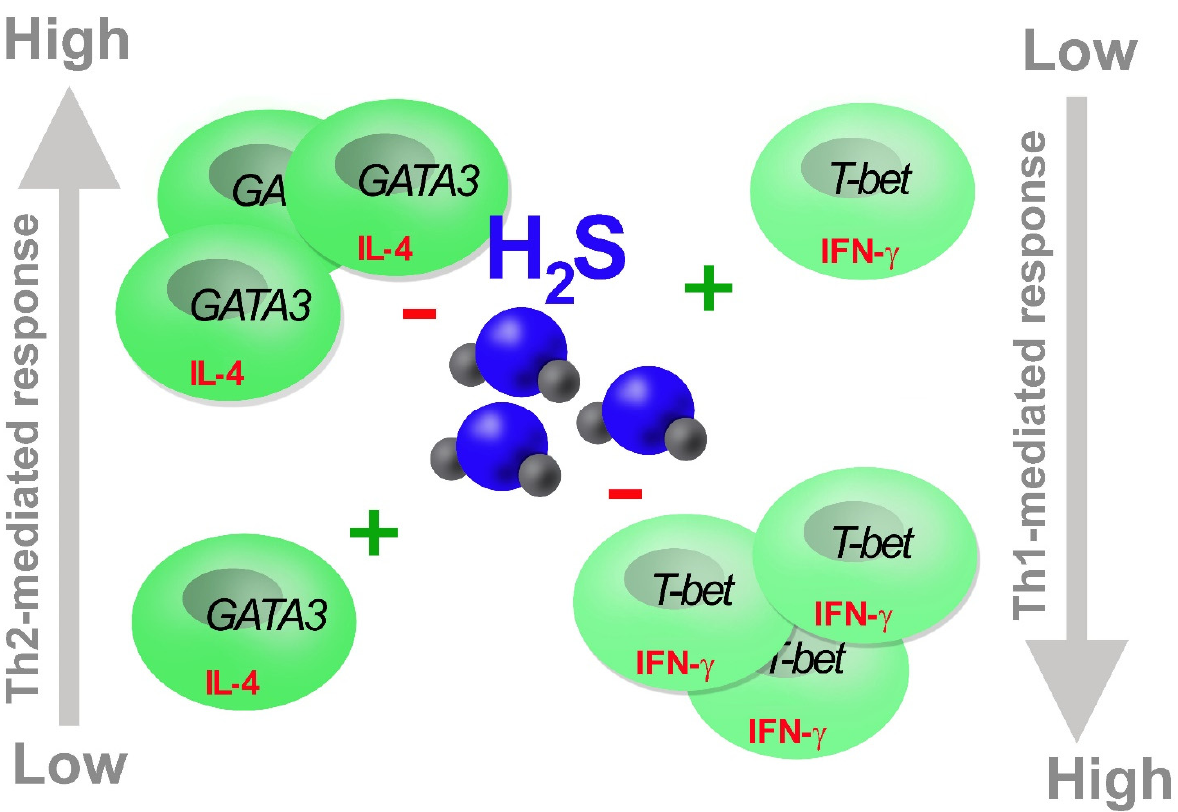
Figure 4. H 2 S balances Th1/Th2 response. H 2 S boosts (+) Th response limiting ( − ) excessive Th proliferation and activity obtaining an optimal balancing of Th1 and Th2 effects.